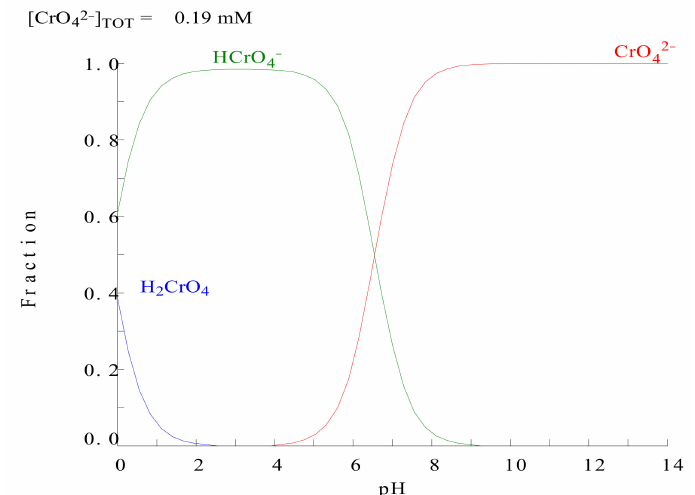
Figure 2. Cr(VI) speciation as pH function [35].